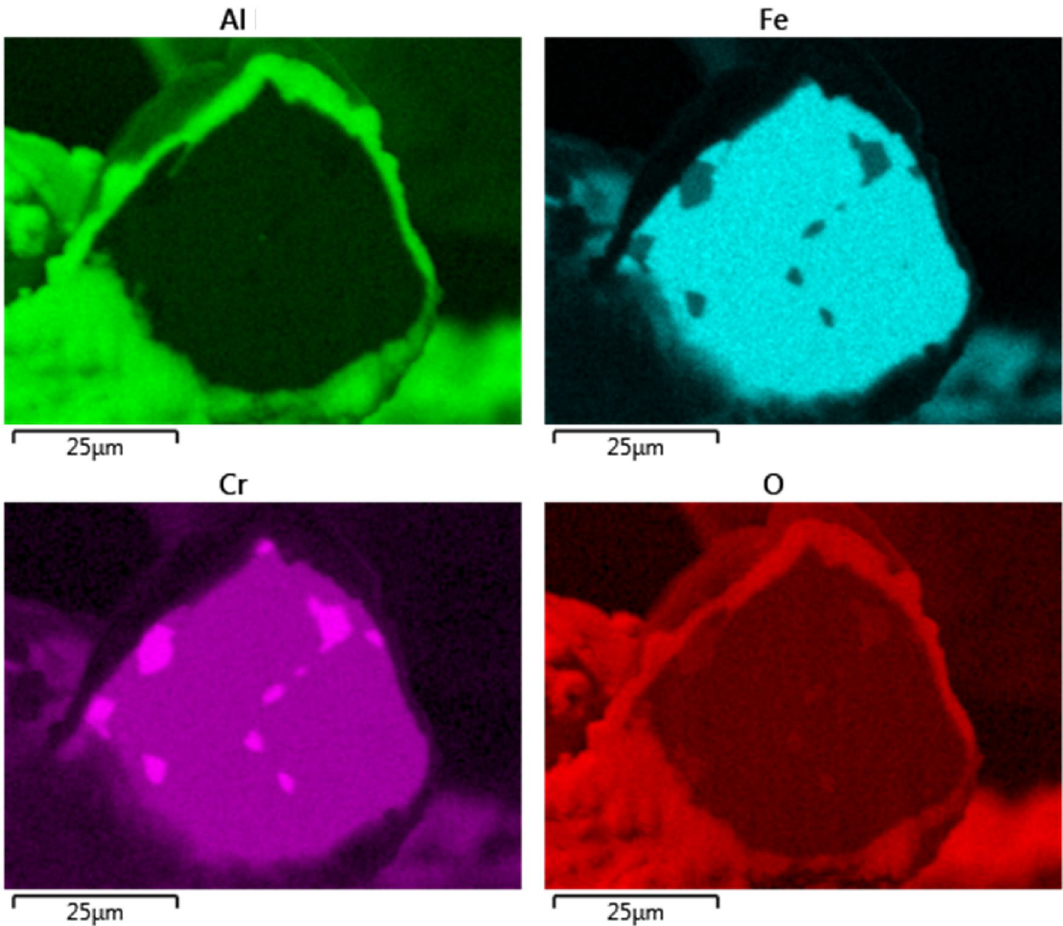
Figure 12. EDS mapping of iron, chromium, aluminum, and oxygen of Sample